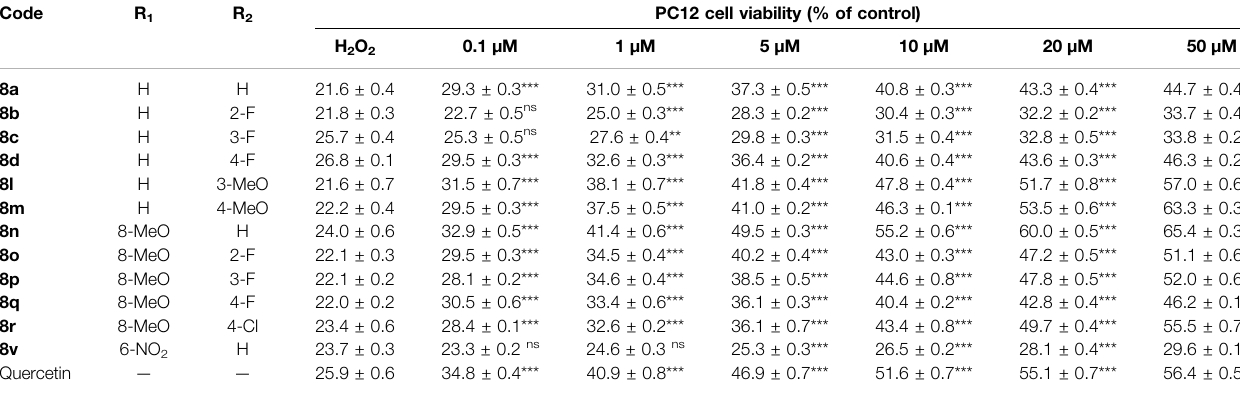
TABLE 2 | Protective effect of the selected compounds against H 2 O 2 -induced PC12 cell death at different concentrations. a